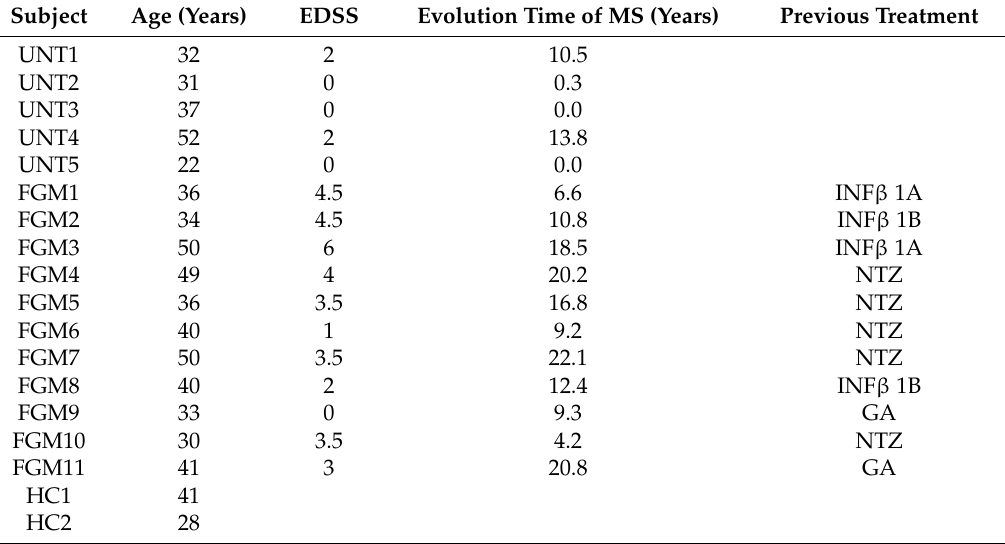
Table 1. Clinical characteristics of individuals